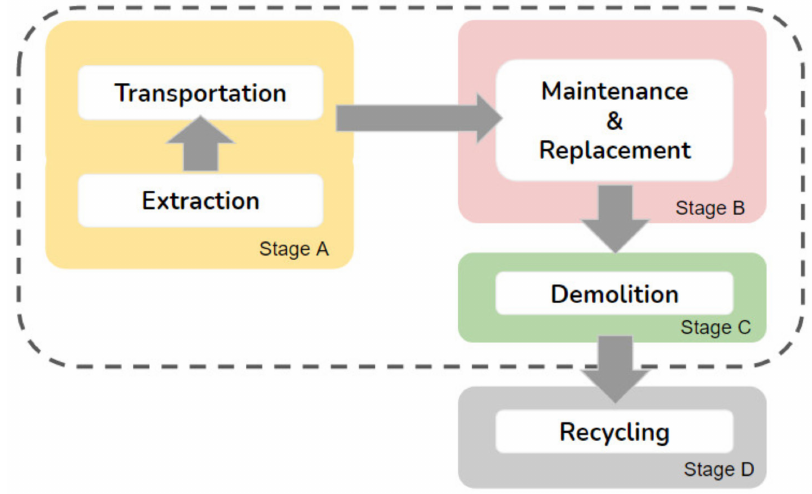
Figure 5. Environmental impact analysis system boundary. Table 4. Environmental impact analysis results for stages A1 to A4.